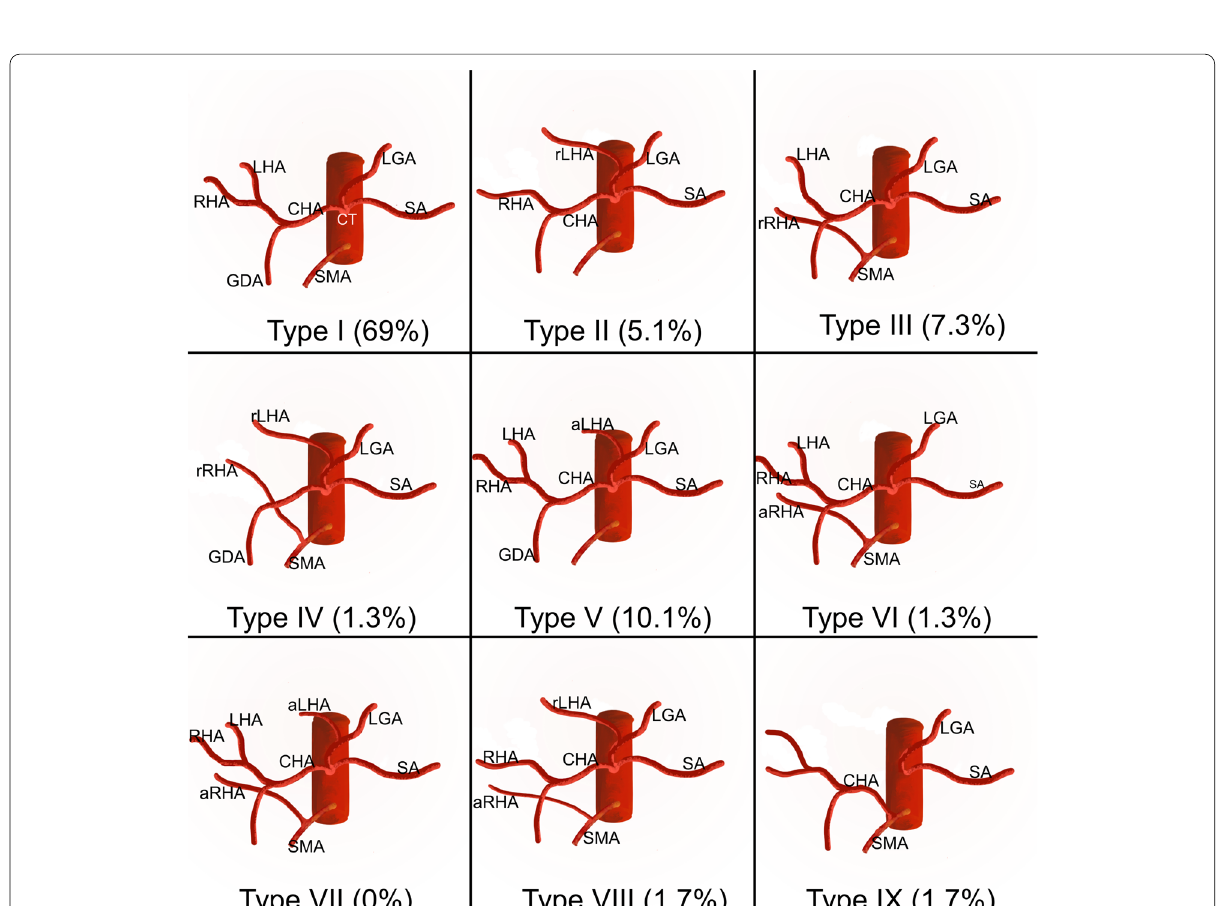
Fig. 1 Schematic representation of hepatic artery variants in our study (according to the Michel’s classification and excluding the rare miscellaneous